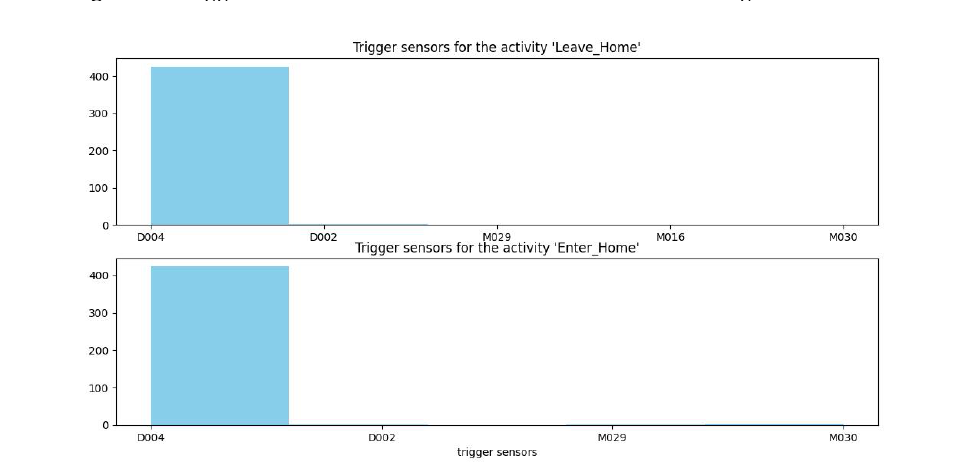
Figure 13. Trigger sensors for the activities bed to toilet, work, eating, and wash dishes.